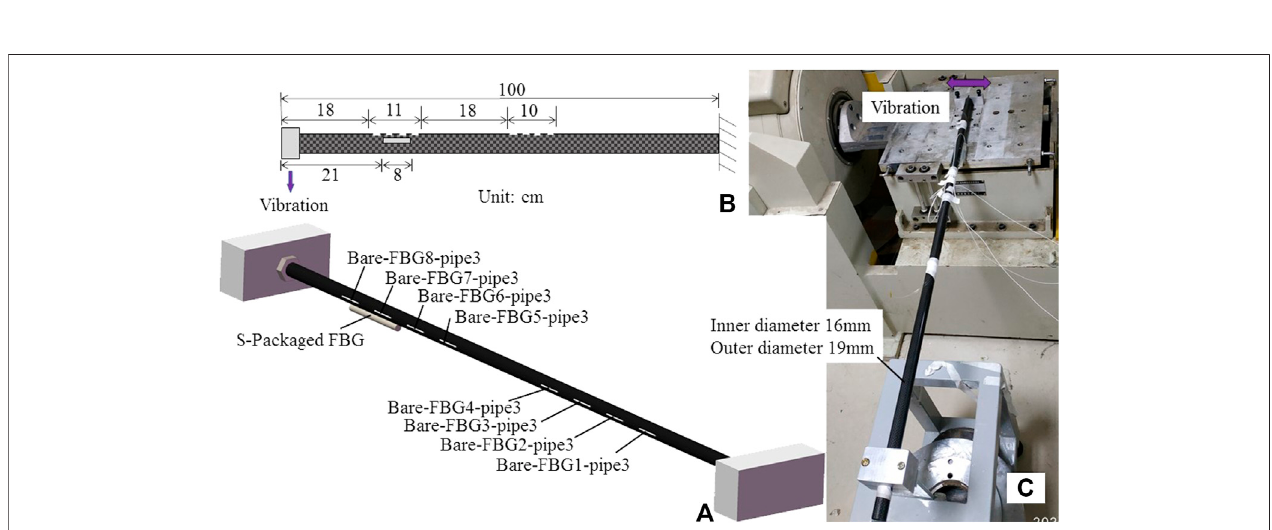
FIGURE 5 | Setup of pipe3: (A) layout of surface-attached FBGs in series; (B) position of FBGs in series; (C) testing photo.